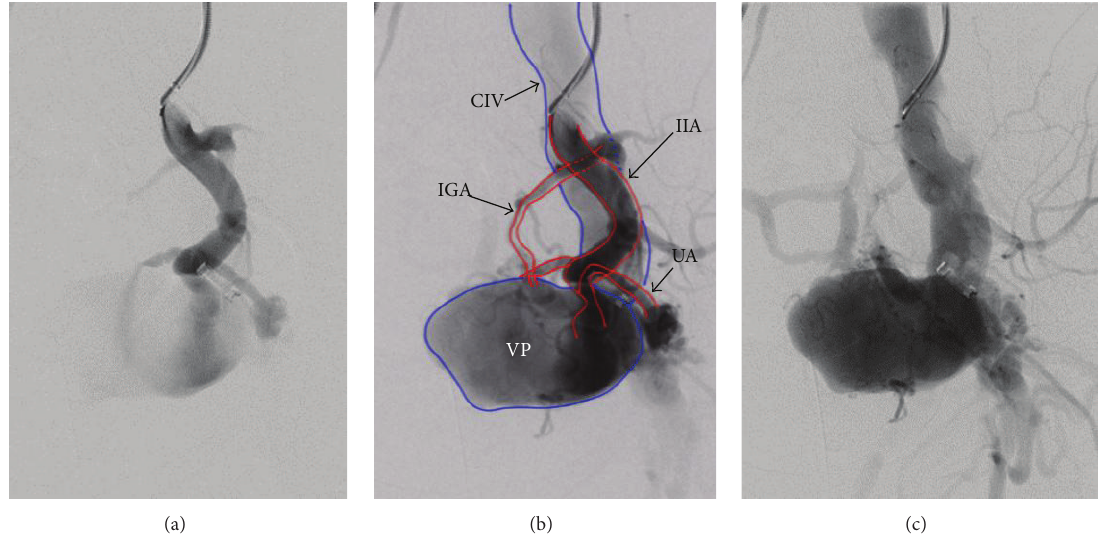
Figure 2: Digital subtraction angiography (DSA) of the pelvic mass. (a) Catheter in the left internal iliac artery. (b) Illustration of the arteriovenous fistula: “red: arterial feeding branches; blue: venous pouch and left common iliac vein; IIA: internal iliac artery; IGA: inferior gluteal artery; UA: uterine artery; CIV: common iliac vein; VP: venous pouch.” (c) Late arterial phase with rapid opacification of the left common iliac vein.